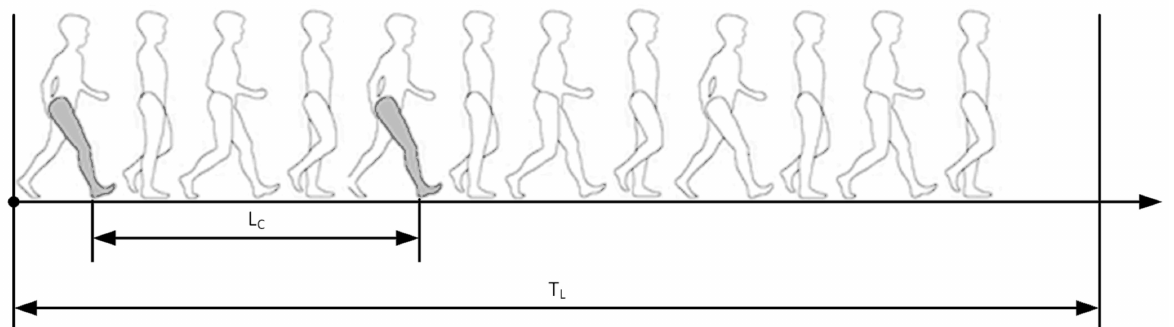
Figure 2. Spatio-temporal variables: T L : track length; L C : gait cycle length. Adapted from